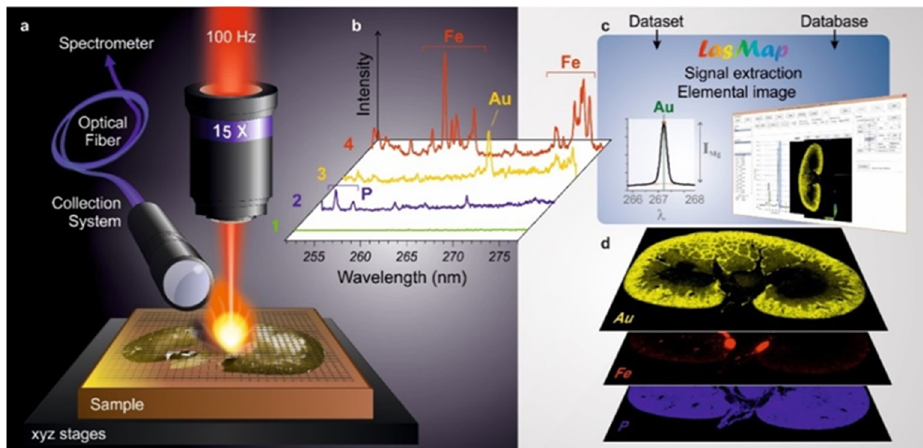
Figure 19. Principle of LIBS-based imaging extracted from Reference [216]. ( a ) Schematic view of a micro-LIBS configuration showing a x15 microscope lens used to focus the laser pulse, the motorized platform supporting the sample and an optical detection system connected to the spectrometer through an optical fiber. ( b ) Example of single-shot emission spectra recorded in different positions of the sample (i.e., here, a rat kidney sampled 1 h after gold nanoparticles administration) with characteristic emission lines of phosphorous (P), iron (Fe) and gold (Au). ( c ) Principle of data extraction using appropriate software. ( d ) Example of LIBS elemental images of Au (yellow), Fe (red) and P (blue).